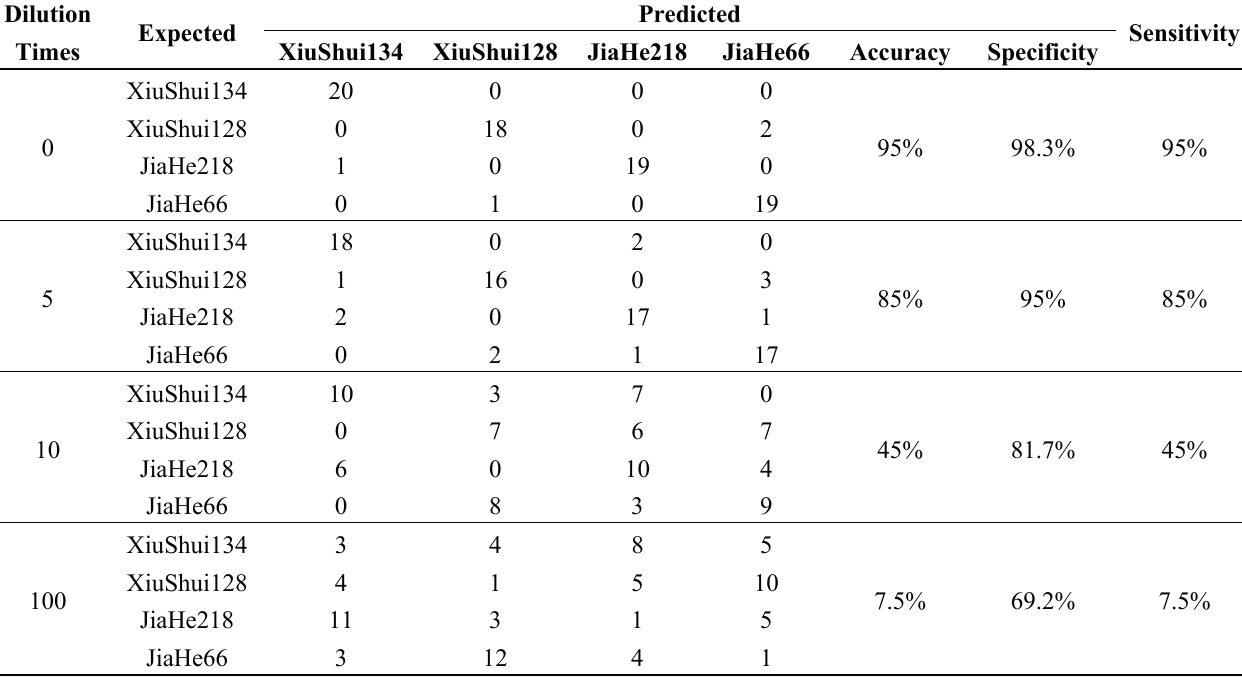
Table 4. Prediction results of RBF neural network using leave-one-out cross validation approach.